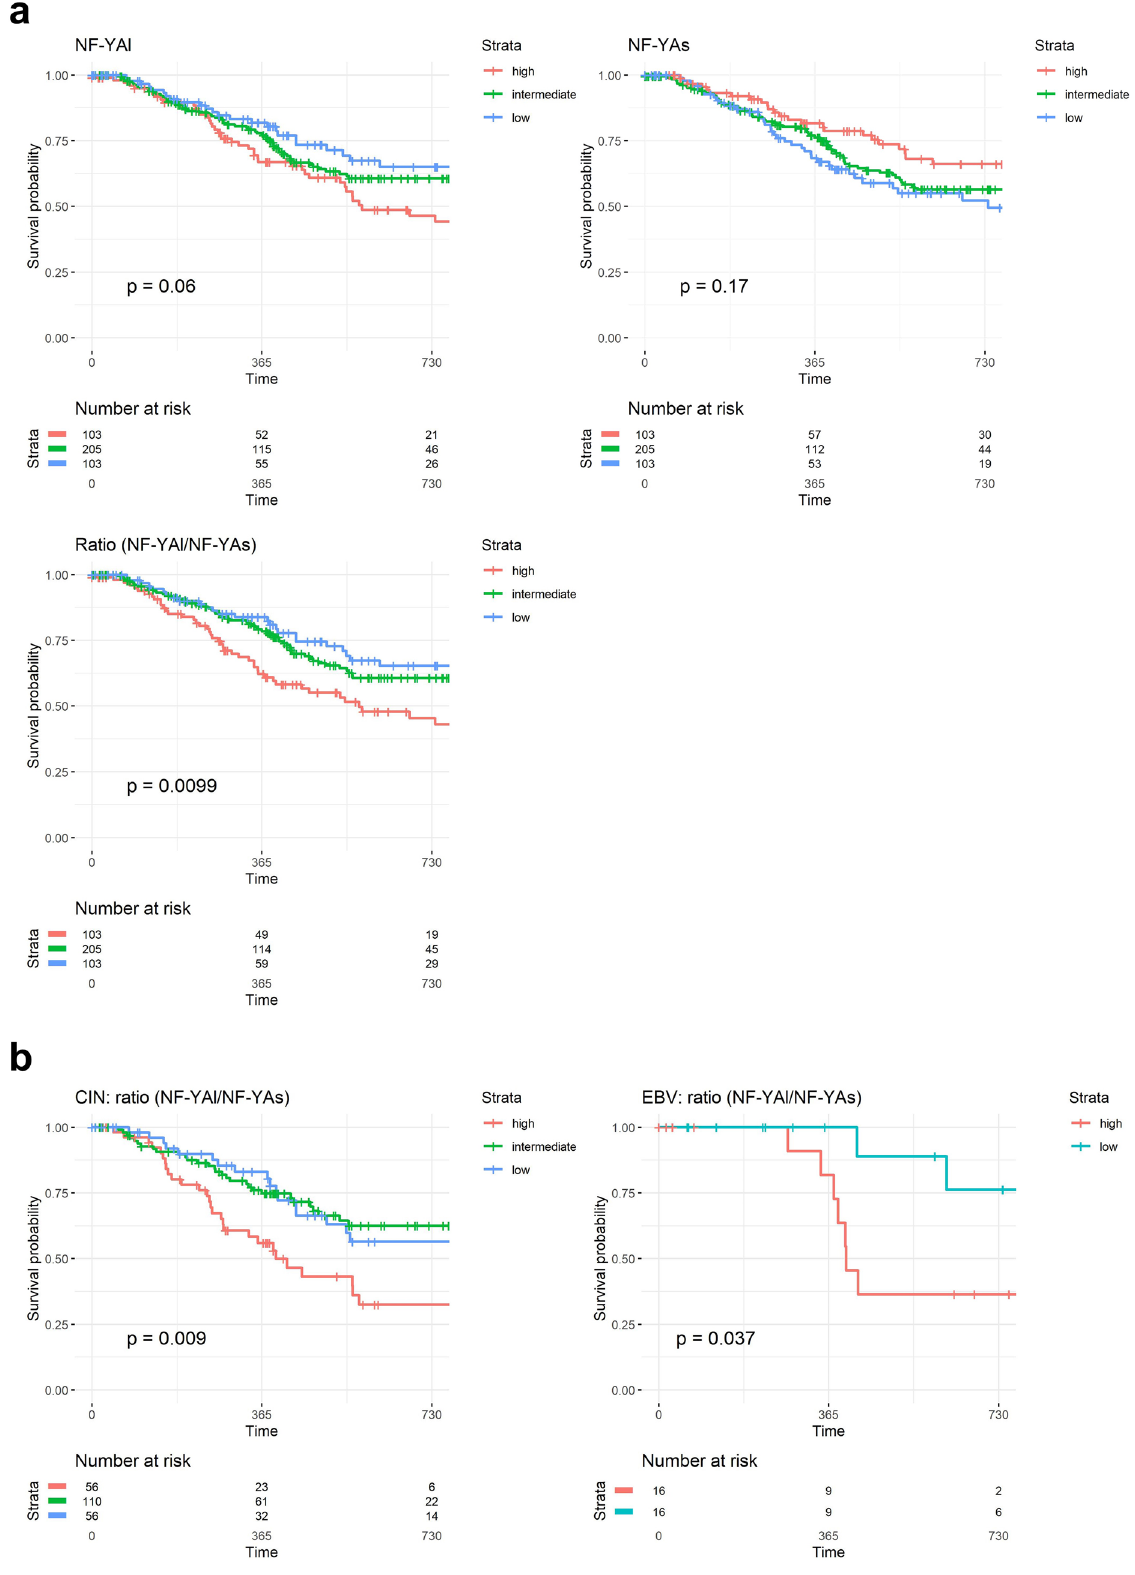
Figure 4. Clinical outcome of NF-Y expression according to the TCGA classification. ( a ) Upper Panels, Progression-Free-Interval-PFI- curves of survival probability of STAD tumors with stratification according to quartiles of NF-YA long and short isoforms (Intermediate, High and Low). PFI curves of NF-YAl/NF-YAs ratios are shown in the Lower Panel. We stratified all available tumors in the three groups according to the TPM levels: Low = first quartile, high = fourth quartile and intermediate for values included in the two middle quartiles. p values are calculated using the log-rank test. ( b ) PFI curves of the NF-YAl/NF-YAs ratios in the CIN (Left Panel) and EBV tumors (Right Panel). In this latter case, we stratified samples in two bins, High (third and fourth quartiles) and Low (first and second